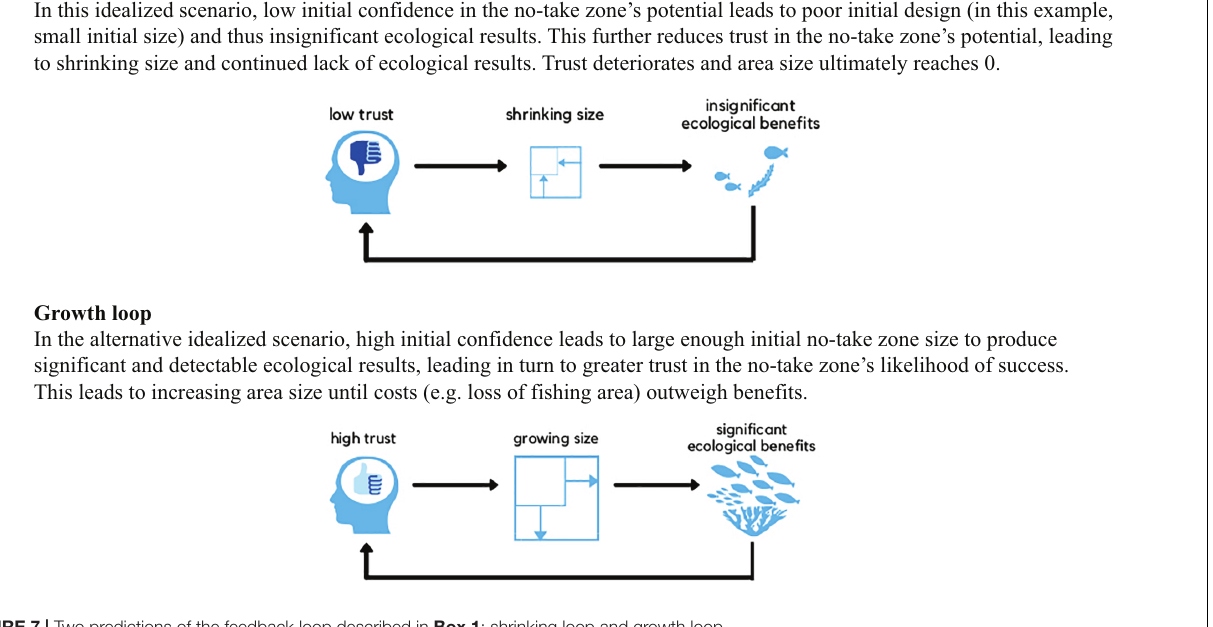
FIGURE 7 | Two predictions of the feedback loop described in Box 1 : shrinking loop and growth